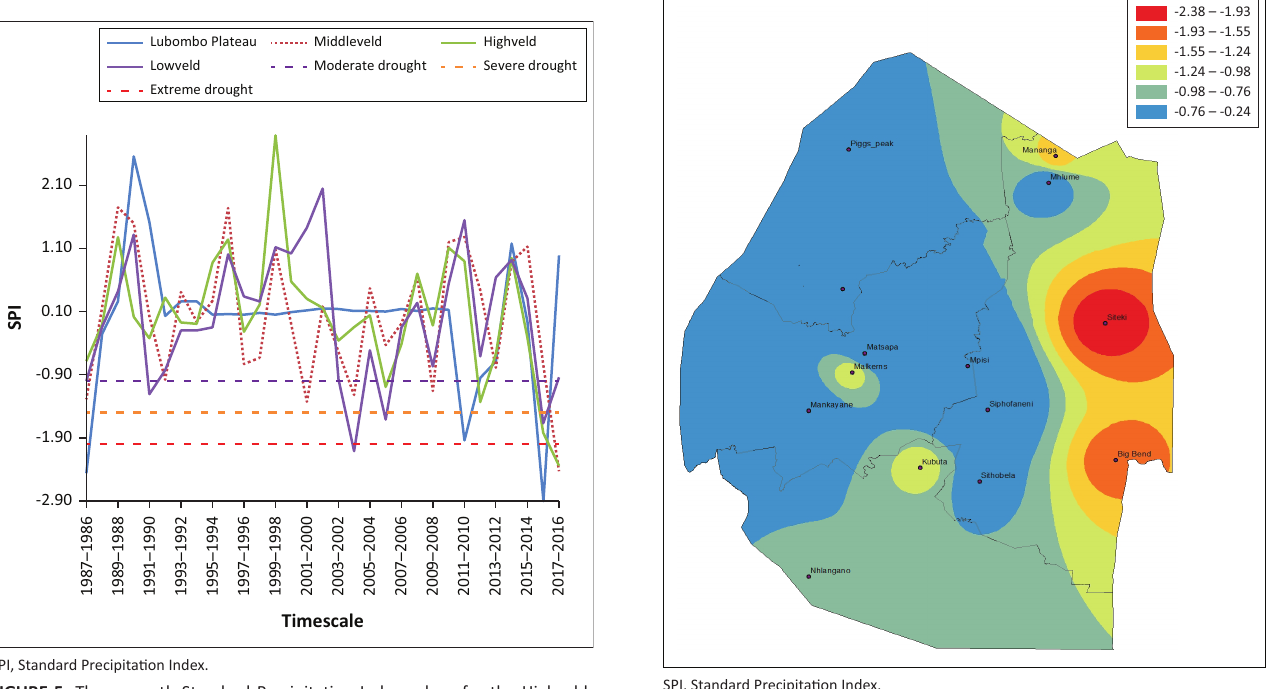
FIGURE 6: Standard Precipitation Index 3-month timescale during 1985–1986.